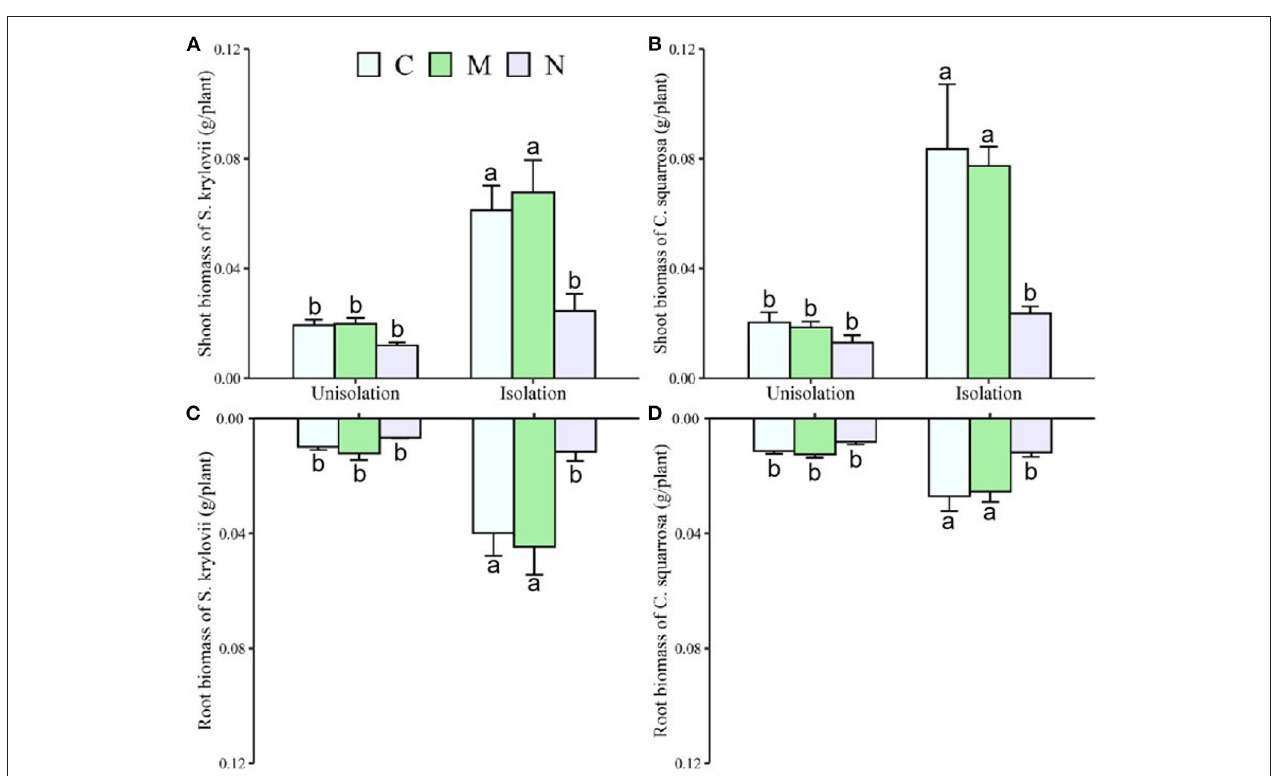
FIGURE 2 | Effects of root isolation on shoot and root biomass of S. krylovii (A,C) and C. squarrosa (B,D) in control (C), mowing (M), and N addition (N) plots. Different lowercases indicate significant differences among the three treatments at p < 0.05.